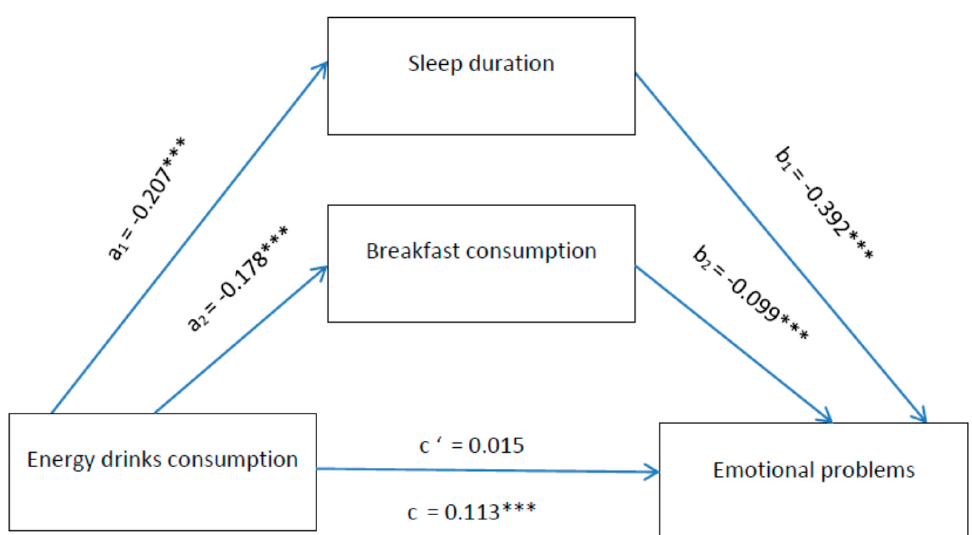
Figure 1. Mediation by sleep duration and breakfast consumption of the relation between EDs and emotional problems. Notes: *** p < 0.001. All presented effects are unstandardised; a n is the effect of ED consumption on mediators; b n is the effect of mediators on emotional problems; c’ is the direct effect of ED consumption on emotional problems, and c is the total effect of ED consumption on emotional problems.